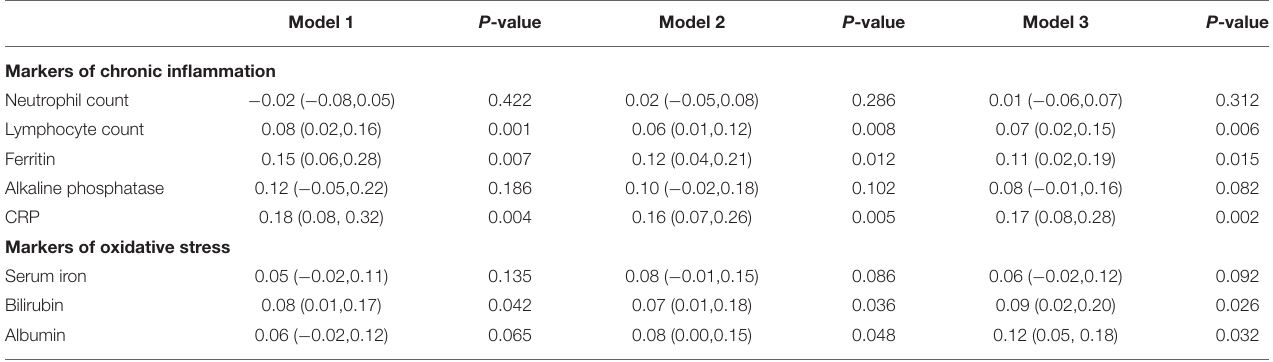
TABLE 2 | β Values of C-DII score in linear regression models after adjusting for different